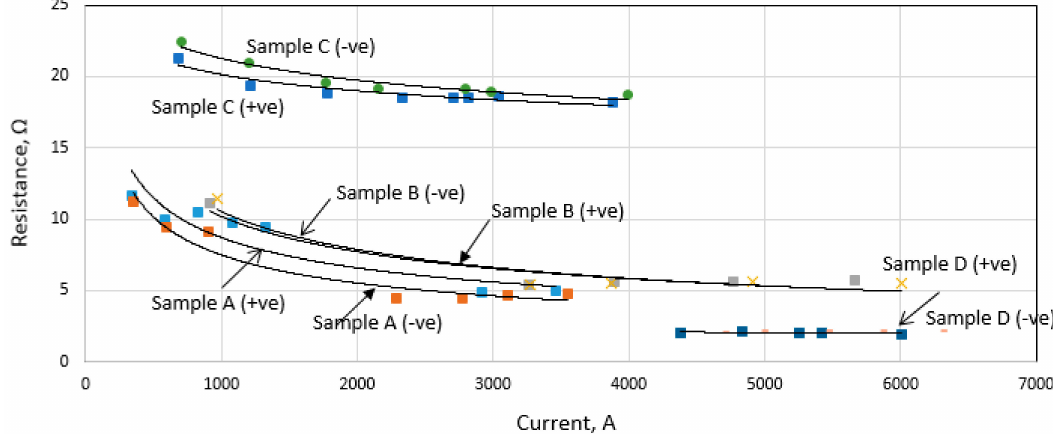
Figure 19. Impulse resistances for electrodes installed in different soil